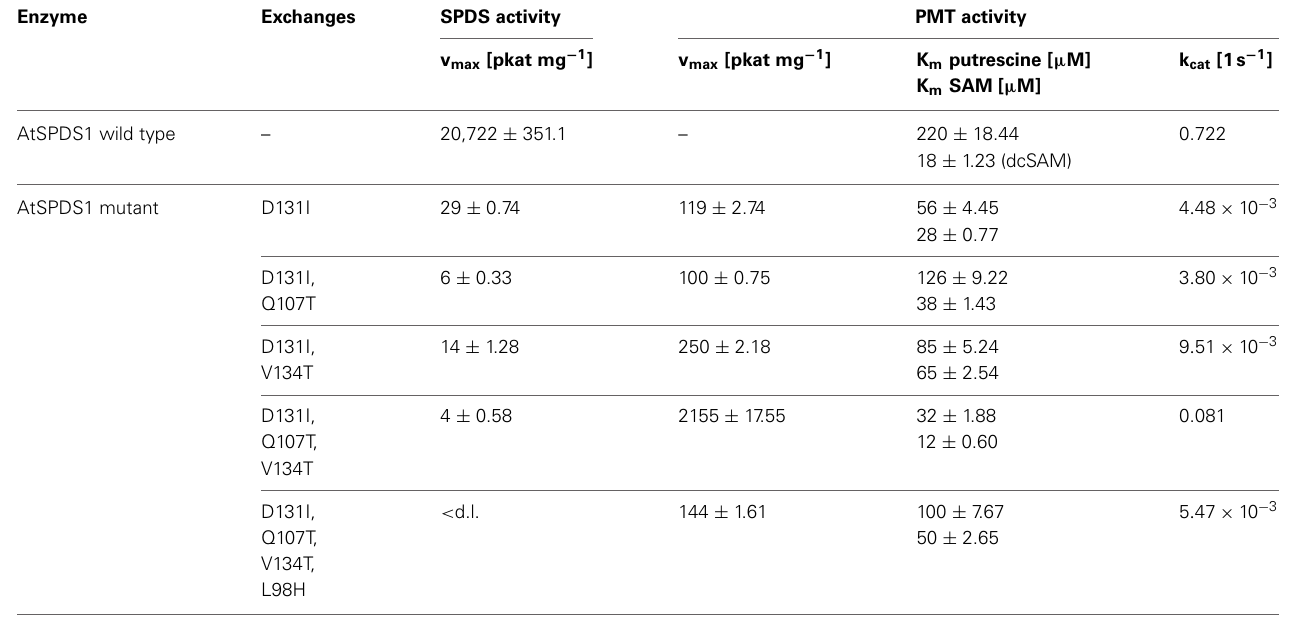
Table 5 | Enzyme activities of AtSPDS1 wild type and